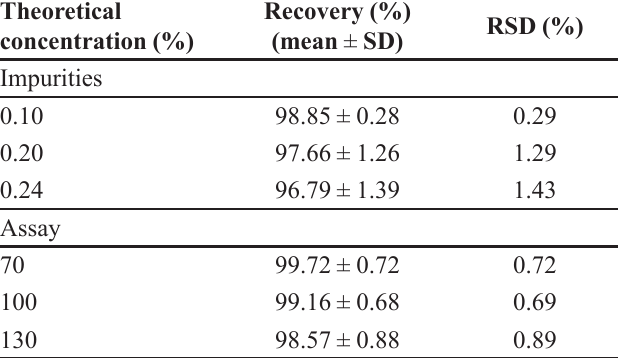
TABLE IV - Amiodarone hydrochloride recovery (data are